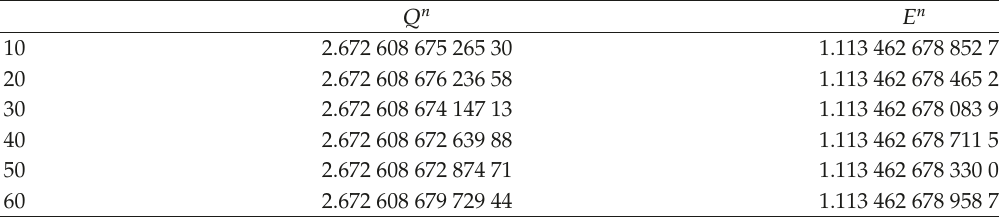
Table 5: Discrete mass Q n and discrete energy E n with τ (cid:7) h (cid:7) 0 . 1 at various t for p (cid:7)